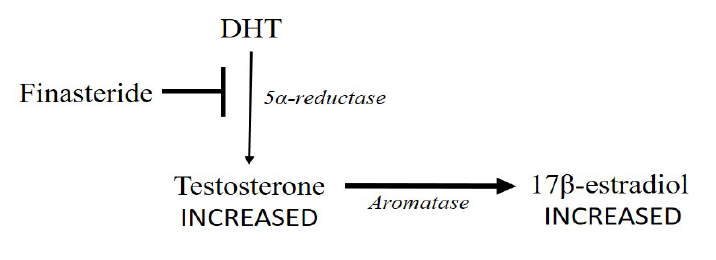
Figure 3. Finasteride blocks ( ) 5α-reductase (thinner arrow) leading to an increase in testosterone concentration. Testosterone conversion into 17β-estradiol by aromatase could increase (thicker